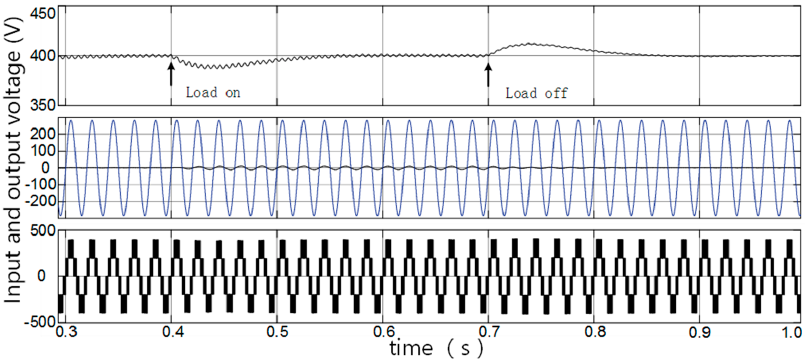
Figure 5. DC-link voltage, input voltage, and current and terminal voltage.